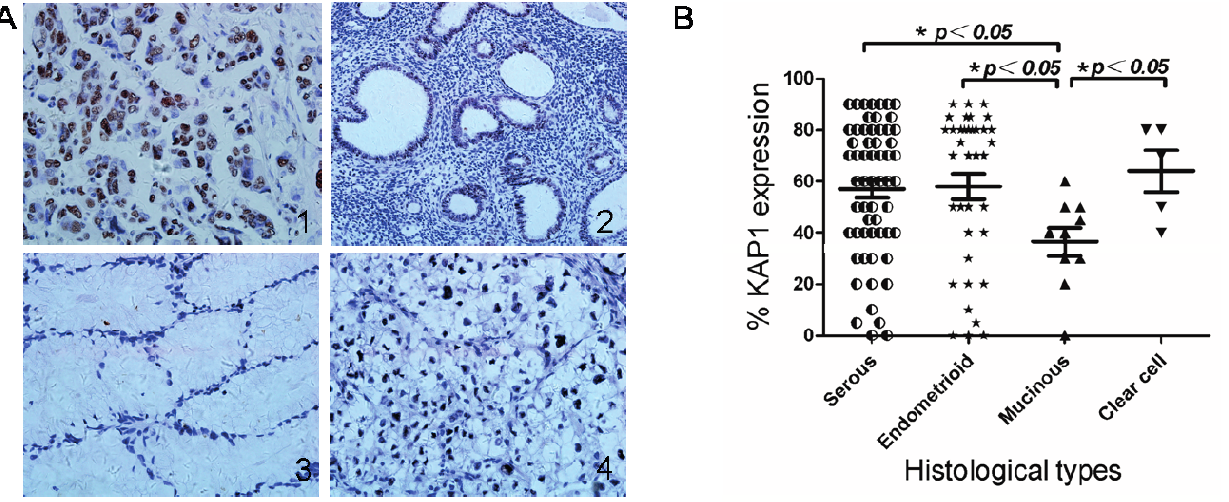
Figure 2. KAP1 expression levels in different histological types ( A 1, serous carcinomas, A 2 endometrioid carcinomas, A 3 mucinous carcinomas and A 4 clear cell adenocarcinomas); ( B ) Significant differences in KAP1 expression levels between serous, endometrioid carcinoma or clear cell adenocarcinoma and mucinous carcinoma. ( * p <